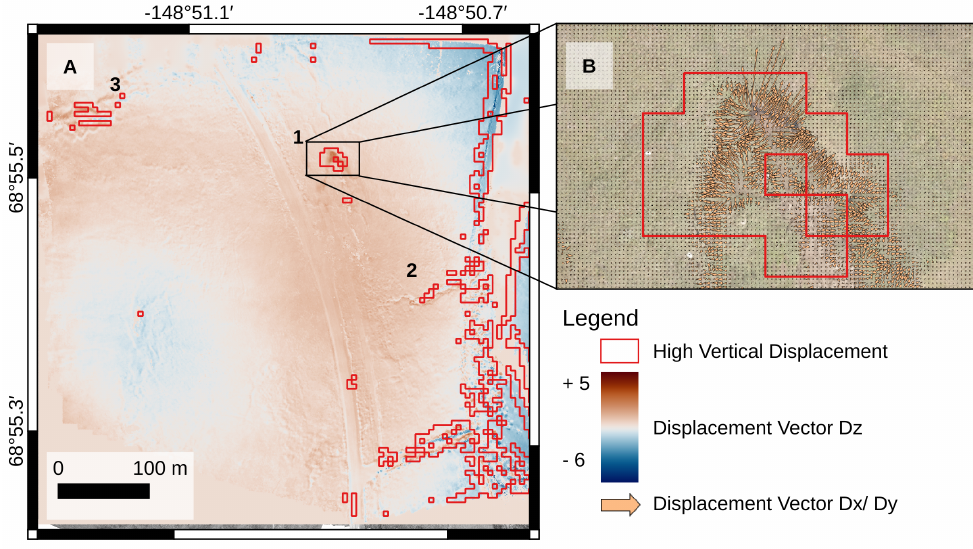
Figure 7. ( A ) Vertical displacement vector Dz in the study area. The overlying pixel mask shows areas with a high image gradient, translating to areas with a high difference in vertical displacement values. ( B ) presents the derived directions of the erosion feature and their magnitude as represented by the length of the arrows. Background image in subset ( B ) is the orthophoto mosaic of 2019 as processed in